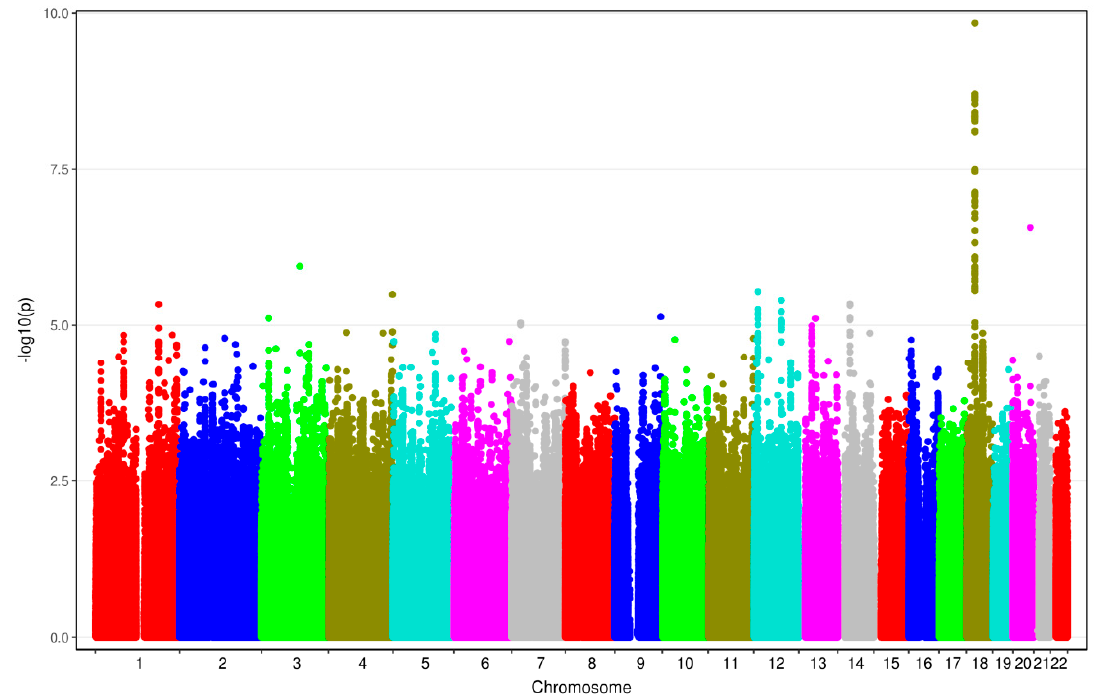
Figure 2. The Manhattan plot shows association levels of severe depressive disorders in patients with coronary artery disease on the autosomal chromosomes.